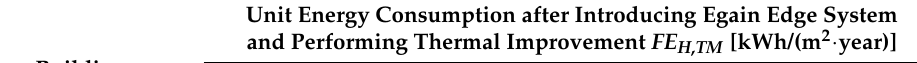
Table 8. Index of annual energy consumption in buildings after thermal improvement and